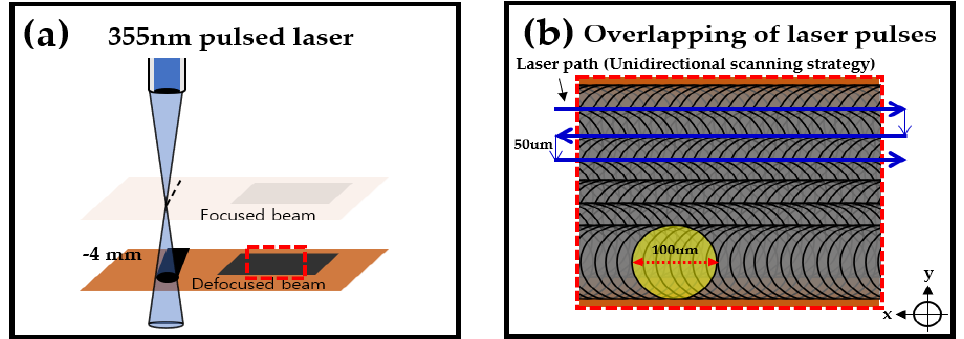
Figure 3. ( a ) Schematic illustration of 355 nm pulsed laser conditions (defocused beam). ( b ) Schematic illustration of the pulse overlap.